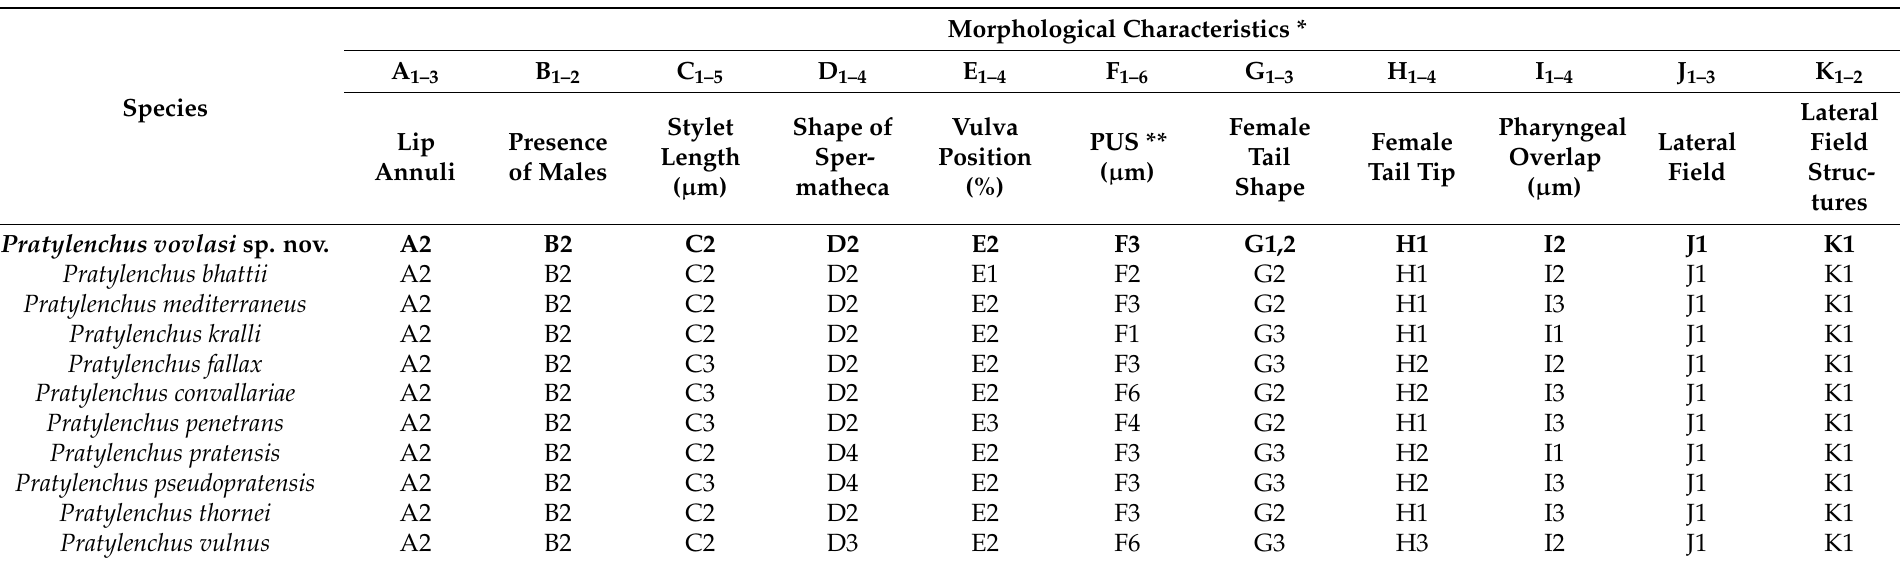
Table 2. Polytomous key of Pratylenchus vovlasi sp. nov. and the morphologically most closely related